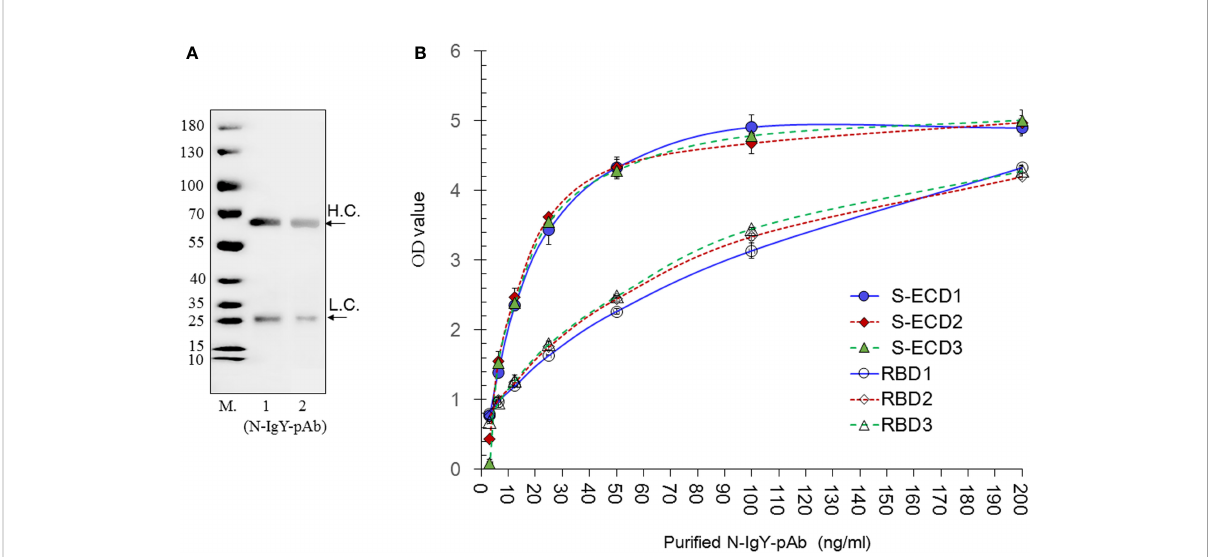
FIGURE 2 Evaluation of the purity, sensitivity and speci fi city of the N-IgY-pAb. (A) SDS PAGE of the N-IgY-pAb. The molecular weight (M) of the N-IgY- pAb were analyzed on a 12% SDS-PAGE. Lane M (Protein marker); lane 1: 2.5 m g N-IgY-pAb; lane 2: 1.25 m g N-IgY-pAb. (B) The immune activities of the N-IgY-pAb. S-ECD- or RBD protein (0.5 m g/mL) using ELISA titer analysis. Thee three batches of puri fi ed N-IgY-pAb with a dilution of 200 – 3.12 ng/mL, respectively. H.L.= heavy chain; L.C. = light chain. H.L.= heavy chain; L.C. = light chain. The mean ± SD was from each sample in replicate two